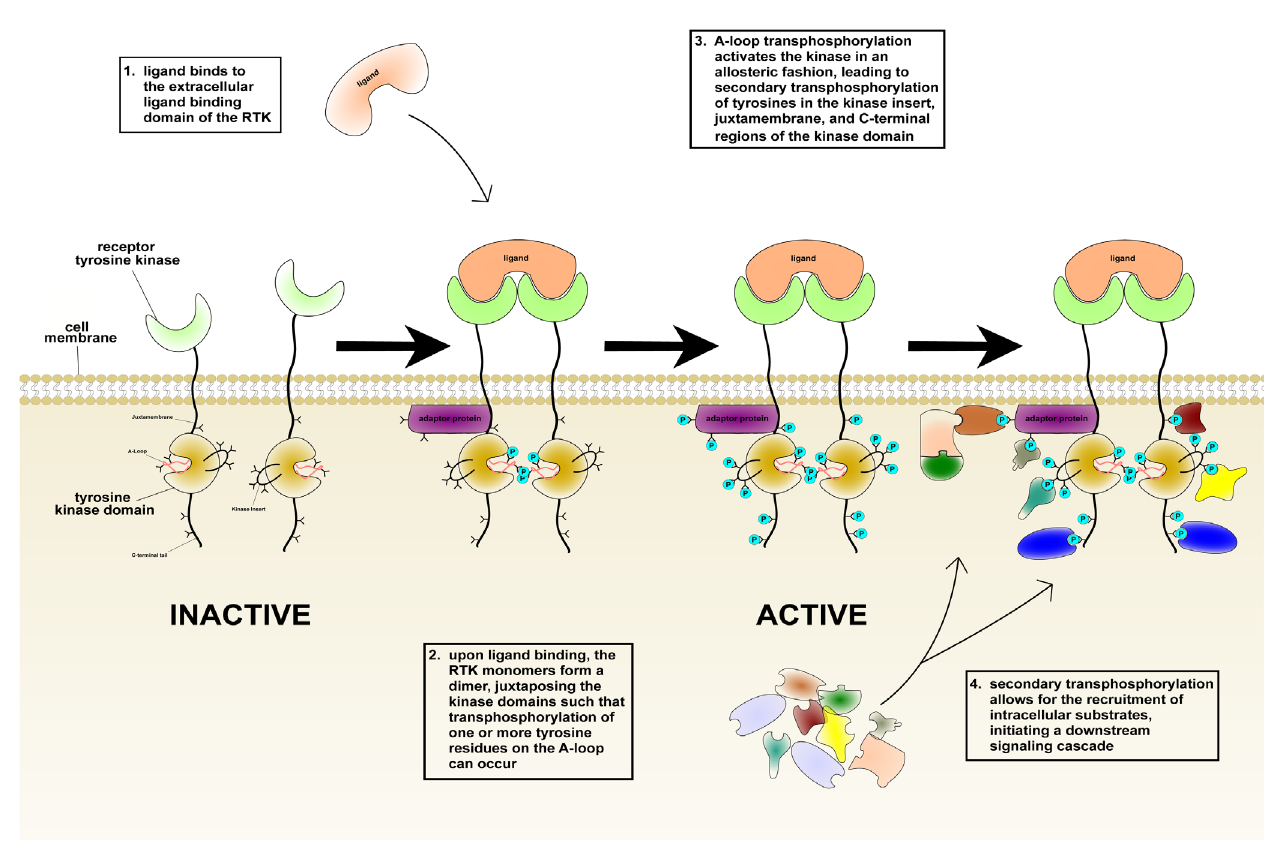
Figure 1. Upon ligand binding, receptor tyrosine kinases (RTKs) dimerize and become activated. From left to right: ligand binding induces RTK dimerization, thus juxtaposing the intracellular kinase domains in a proper orientation/proximity such that transphosphorylation of tyrosines (shown as Y symbols) in the activation loop (A-loop), and hence kinase activation, can occur. This in turn triggers secondary transphosphorylations (shown in turquoise) in the kinase insert, juxtamembrane, and C-terminal tail regions, creating docking sites for the recruitment of distinct intracellular substrates (shown in an assortment of shapes/colors on the lower right). Darker shades are used to denote bound and activated substrates in the right-hand